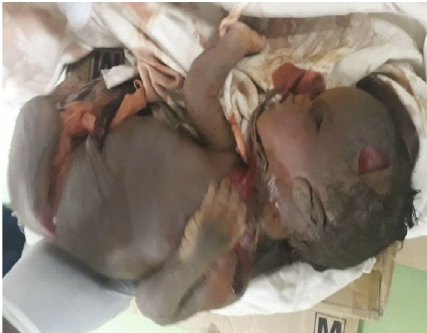
Figure 3: A 2000gm female stillborn with grade-III maceration delivered from the peritoneal